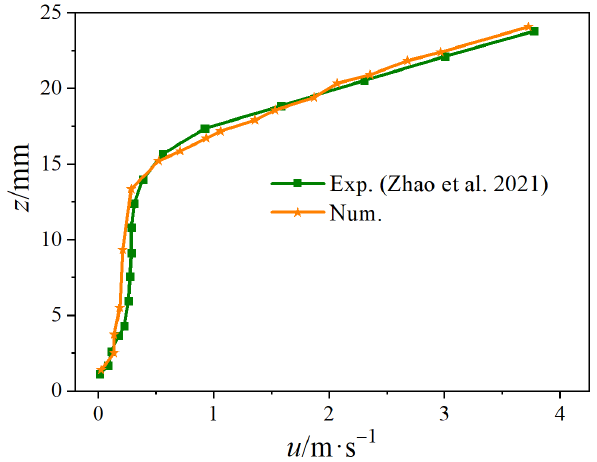
Figure 7. Comparison of velocity profile with experimental data [9].